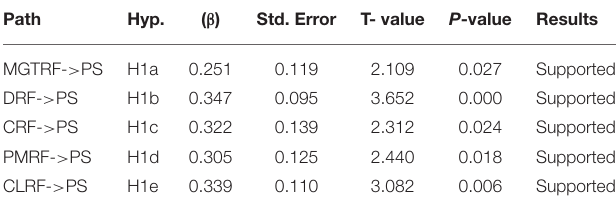
TABLE 12 | Direct analysis (result after